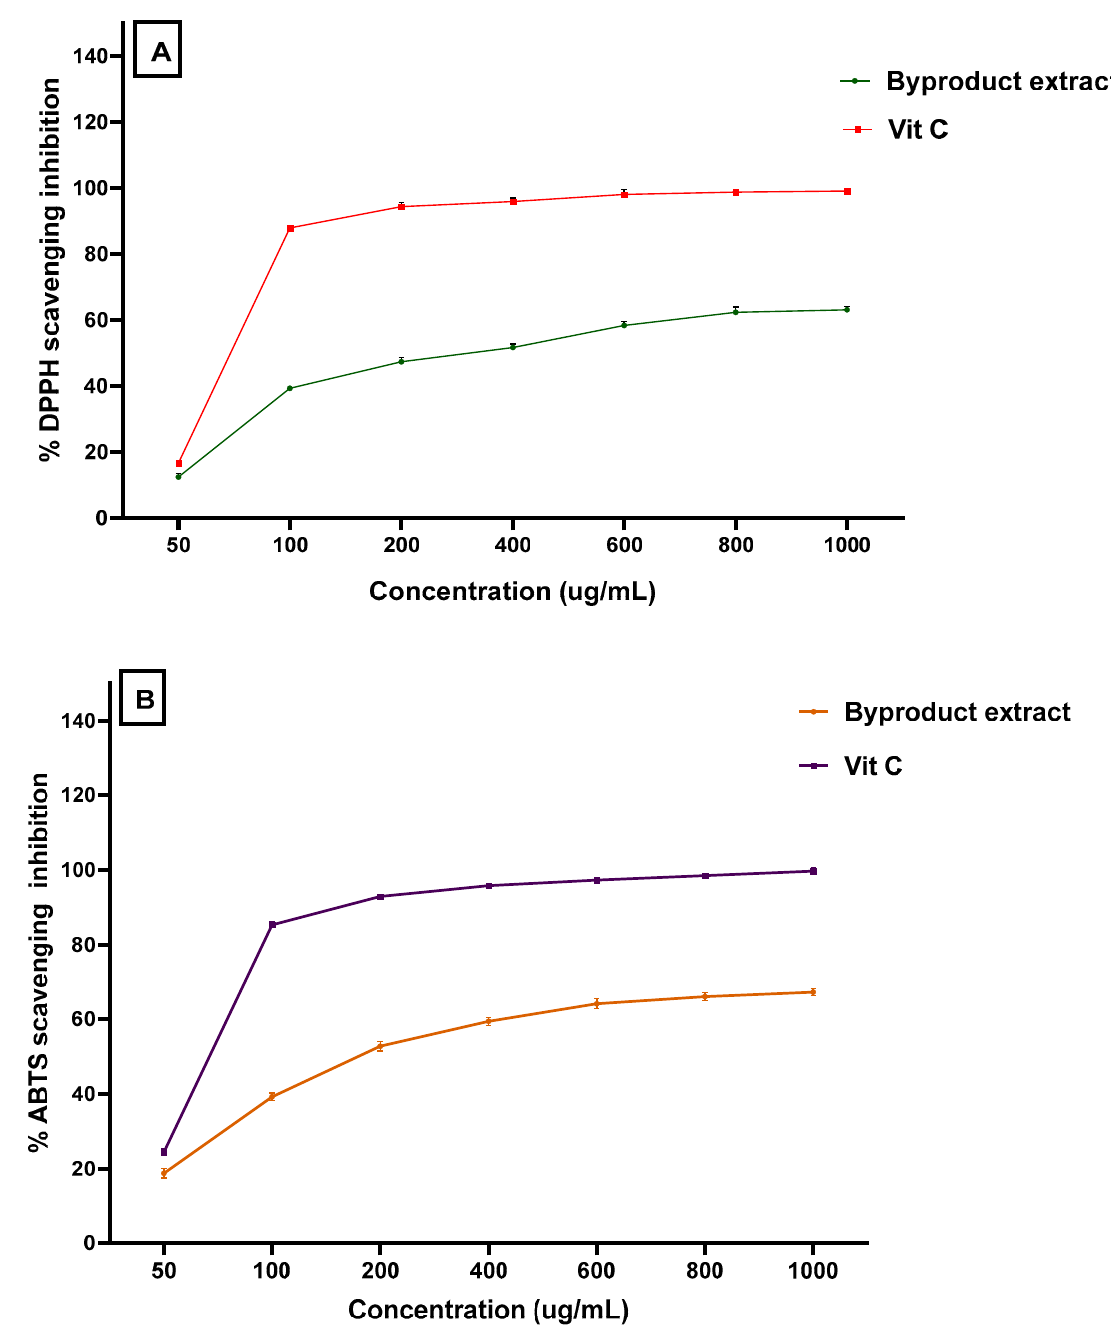
Figure 1. The antioxidant activity of mandarin byproduct using ( A ) DPPH assay, and ( B ) ABTS